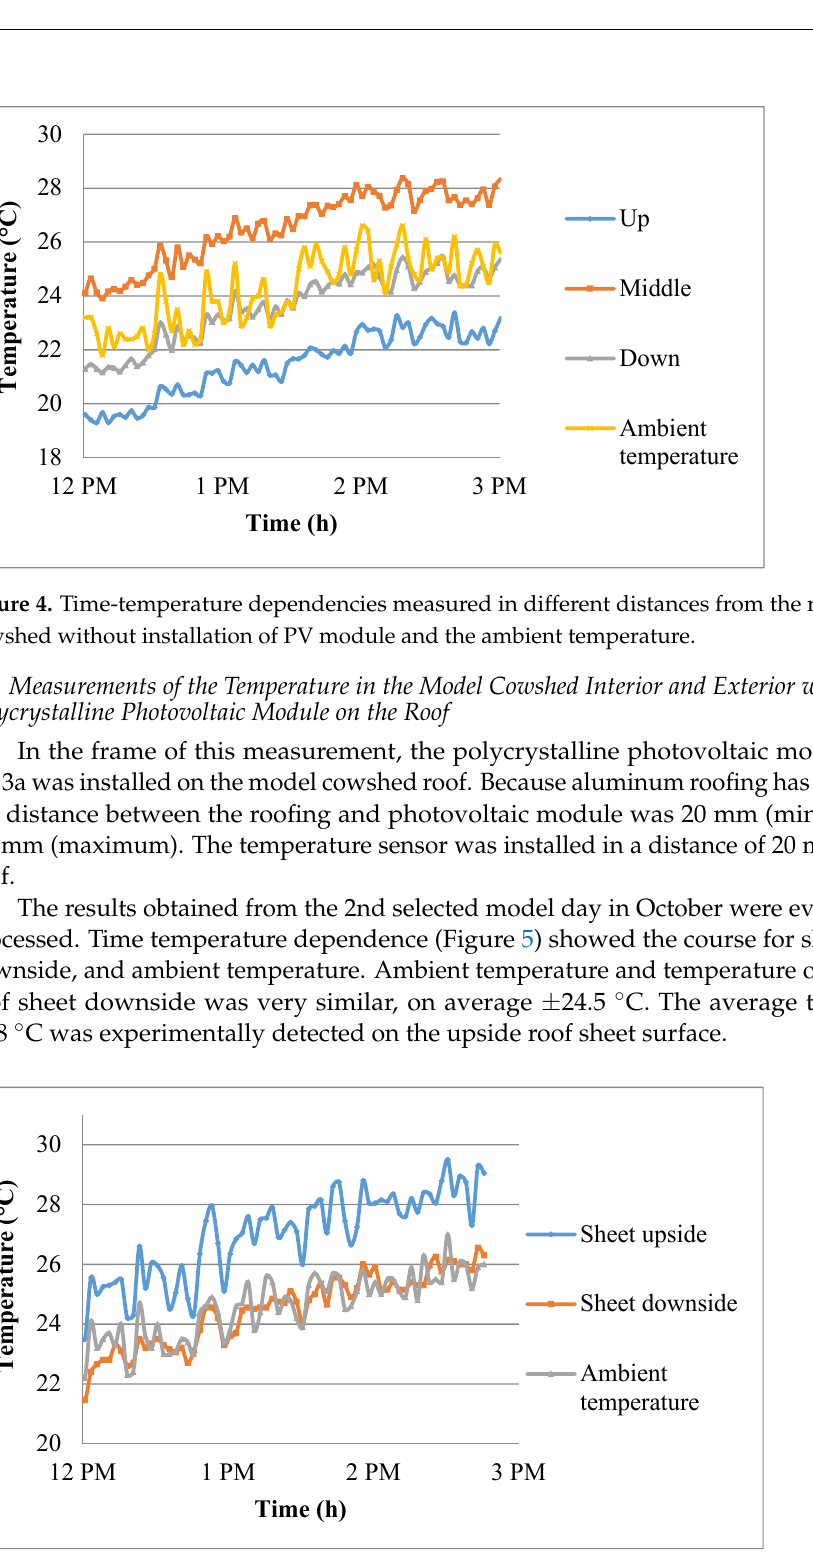
Figure 5. Time dependencies of roof sheet temperature and ambient temperature for model cowshed with installation of polycrystalline PV module.